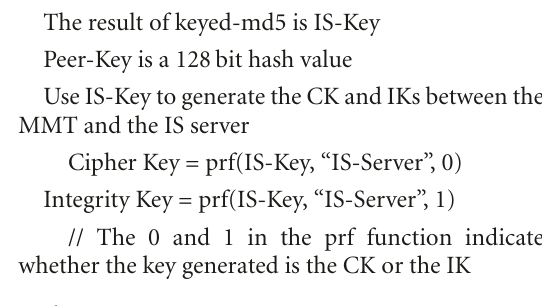
Algorithm 1. Key generation algorithm in MIHPeer().